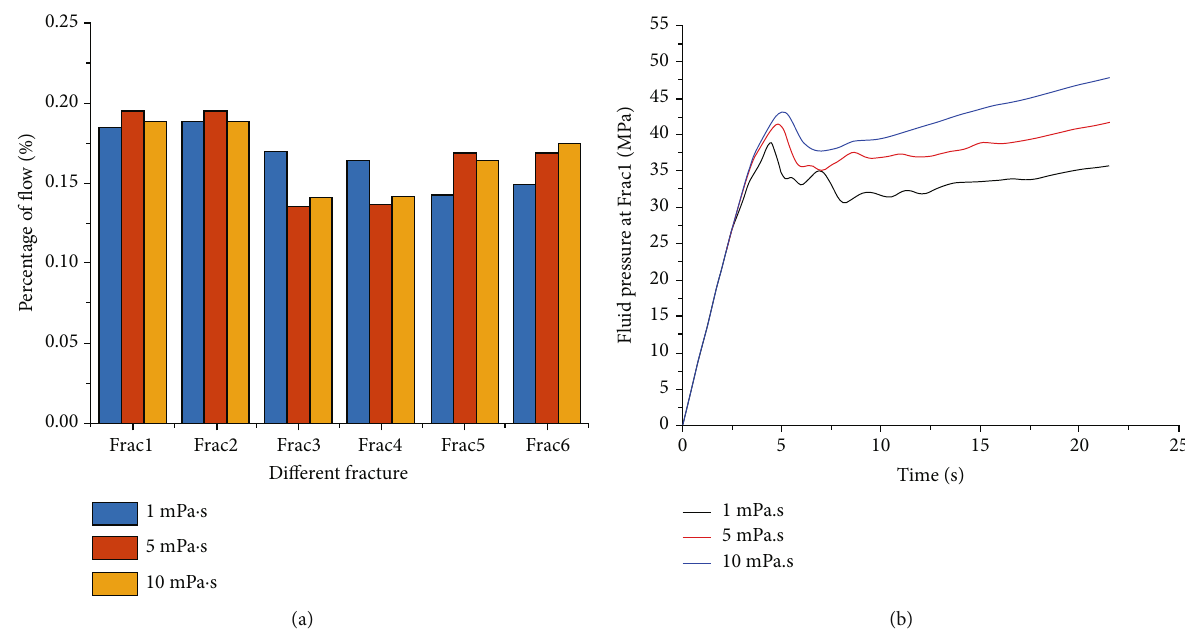
Figure 20: (a) Fluid distribution in fractures and fl uid pressure (b) for varying fl uid viscosities.